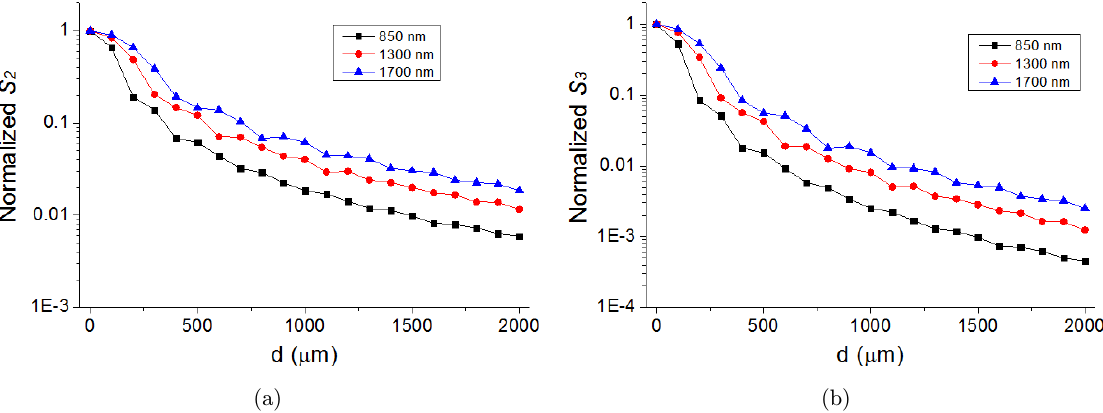
Fig. 1. Normalized (a) S 2 and (b) S 3 vs imaging depth for 850-nm, 1300-nm and 1700-nm excitations. S 2 and S 3 were normalized to those at the surface ( d ¼ 0). Also NA ¼ 1 : 05, n 1 ¼ 1 : 33 and n 2 ¼ 1 :